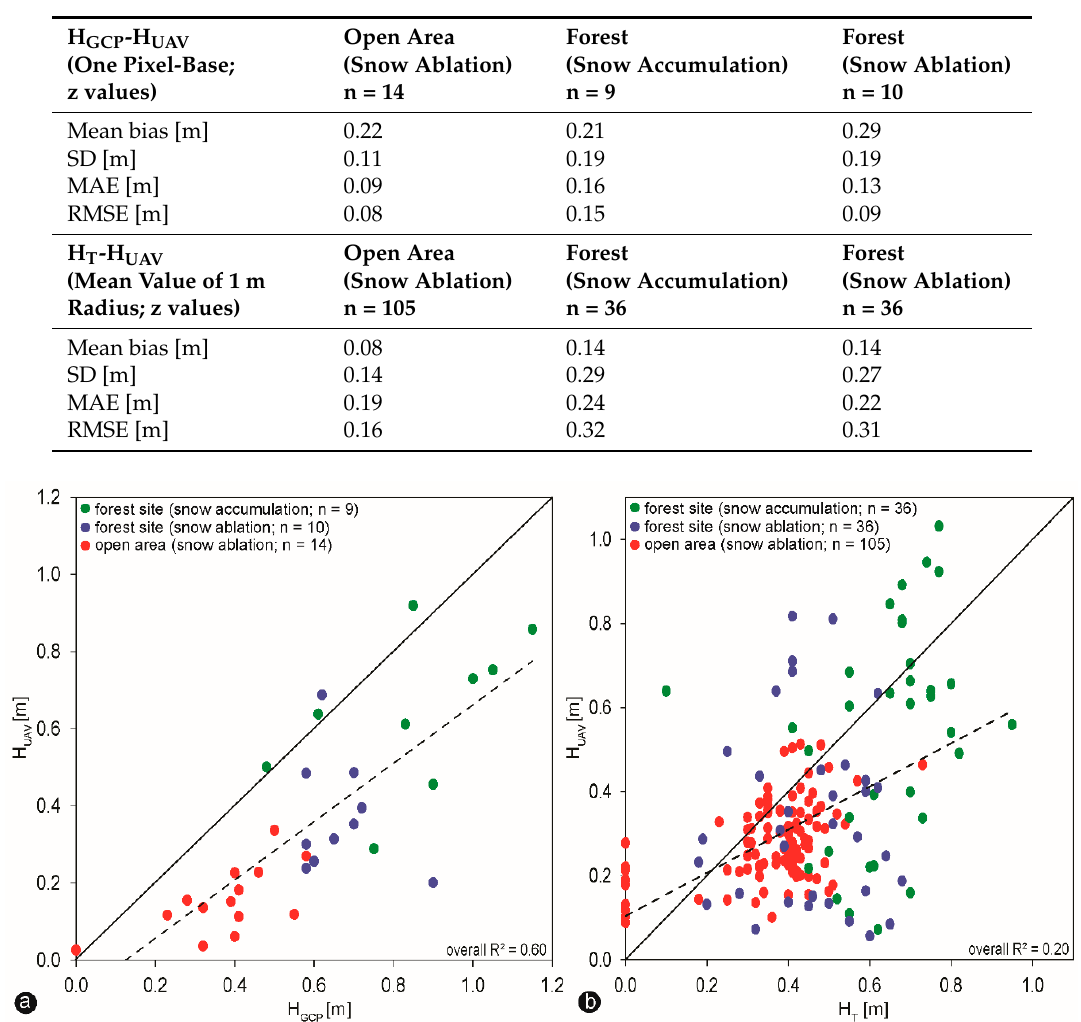
Table 4. Statistics of the evaluation between estimated (H UAV ) snow depths and ground measurements at both study sites. The subtracted H GCP snow depth values from the estimated H UAV measurements are based on one pixel. On the contrary, the subtracted H T samples from the estimated H UAV are based on the mean value within 1 m radius.